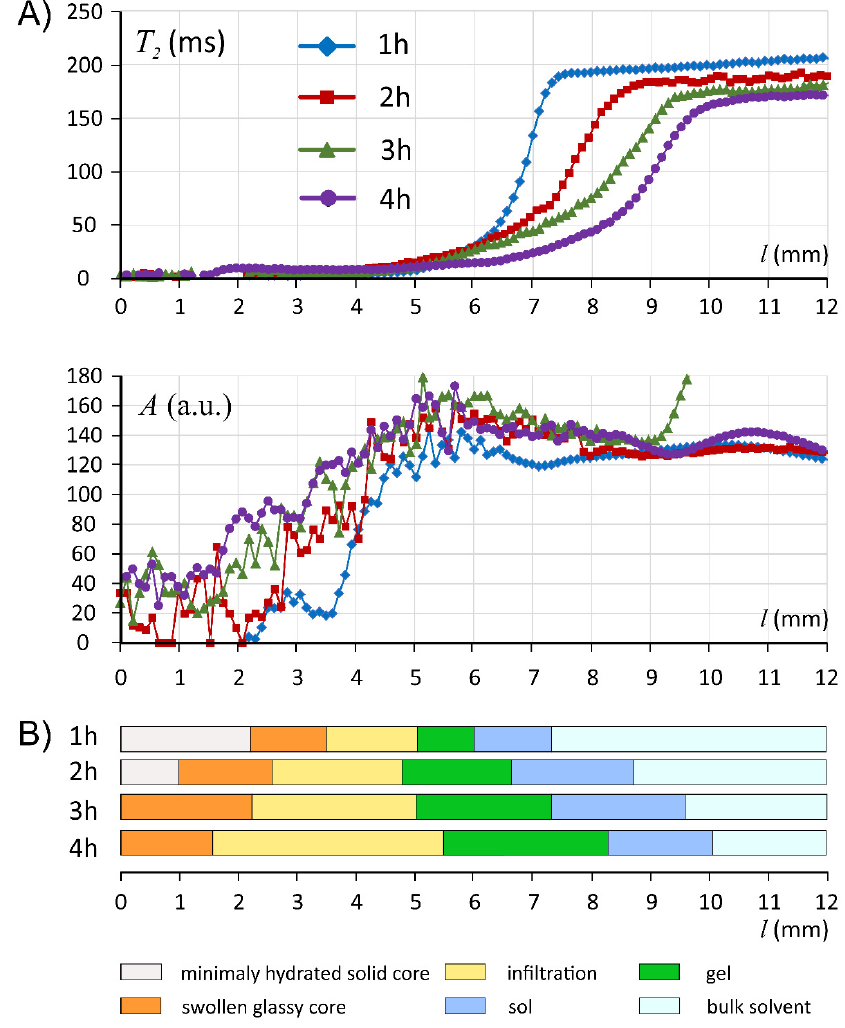
Figure 6. Profiles of MRI derived parameters, T 2 relaxation time and signal amplitude ( A ) and the interpretation of evolution of the ALG/SNA matrix in terms of layers at particular hydration times ( B